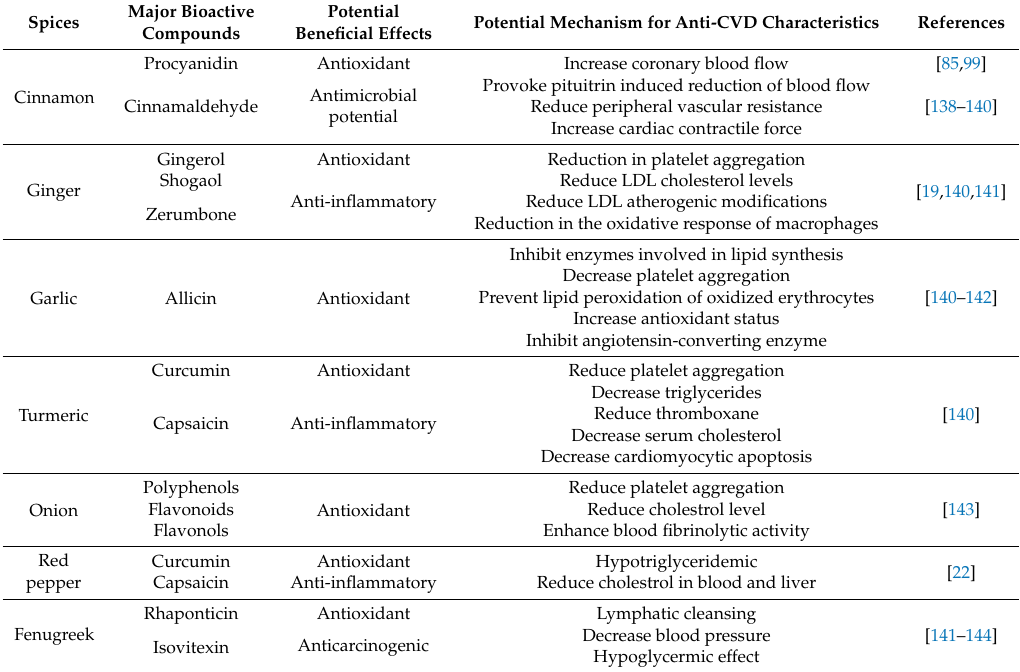
Table 6. Major bioactive compounds of spices with potential beneficial effects for the management of CVD (Cardiovascular